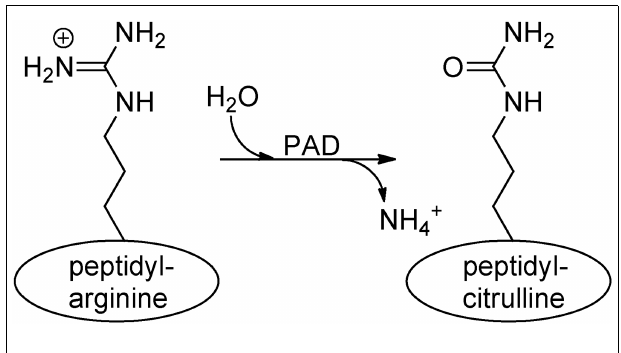
FIGURE 1 | Conversion of arginine into citrulline. Peptidylarginine deiminase (PAD) enzymes convert an arginine residue into